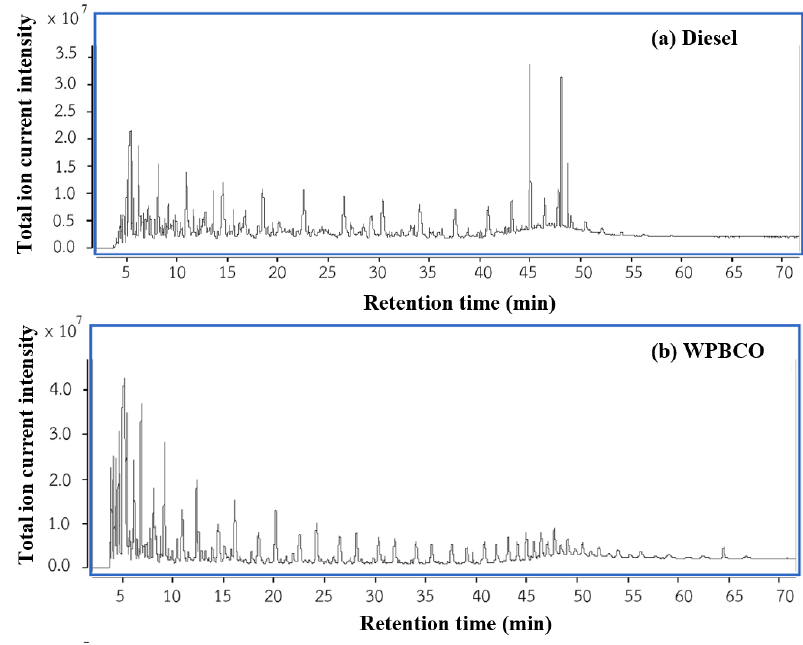
Figure 2. GC – MS chromatograms for ( a ) diesel fuel and ( b ) WPBCO.